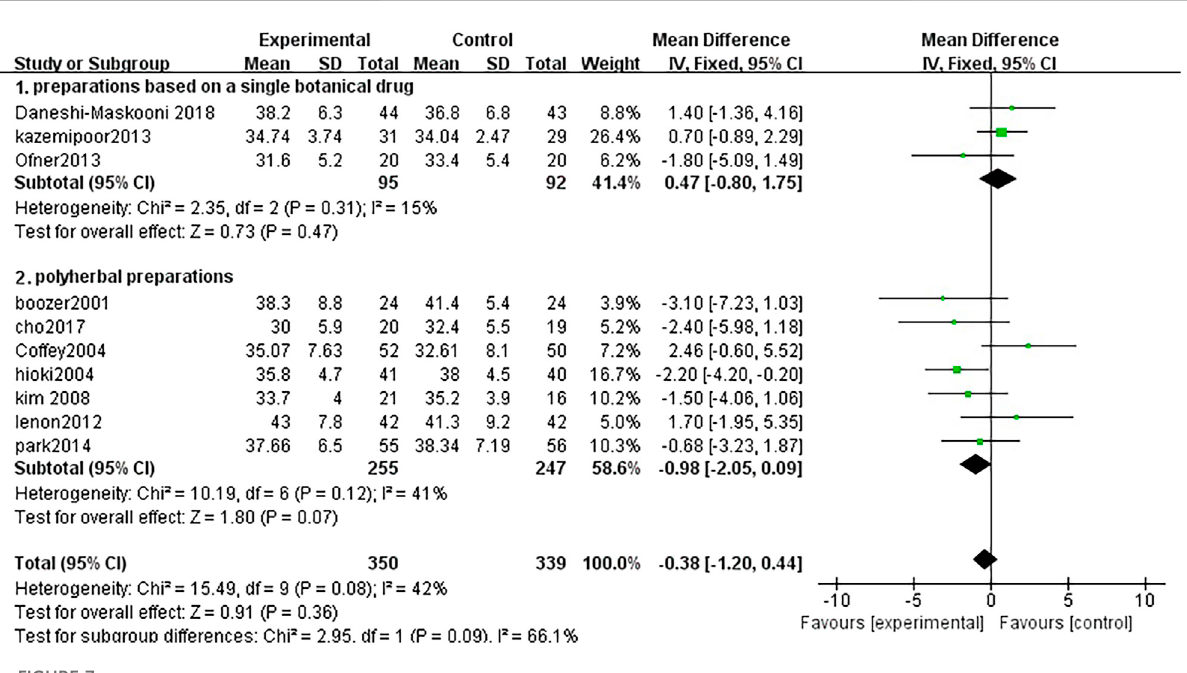
FIGURE 7 Forest plot of body fat rate. Comparison: TCM treatment (I.preparations based on a single botanical drug 2.polyherbal perparations). vs. placeo or blank control.